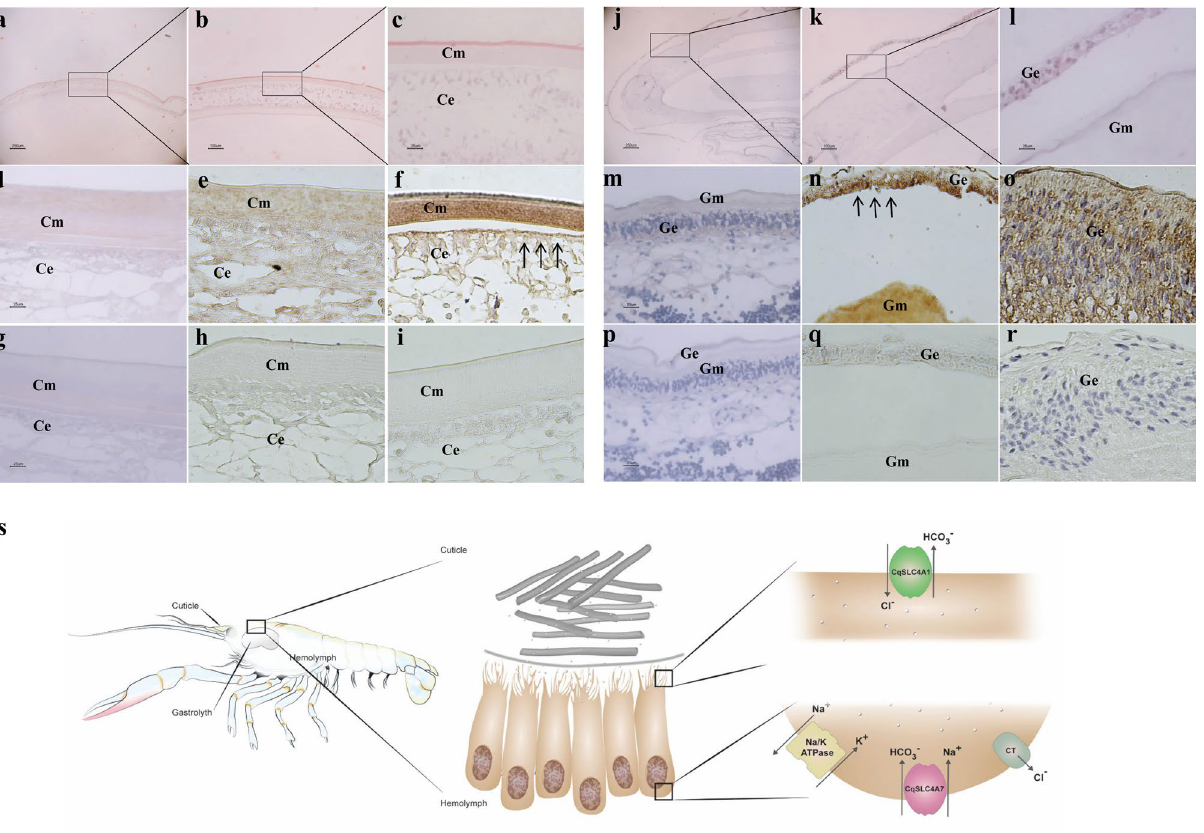
Figure 2. CqSLC4A1 is localized in the apical membrane of the forming epithelia of the cuticular structures of the crayfish during mineralization. ( a–c ) A representative carapace cuticle from a post-molt animal. H&E. ( a ) × 4. Black box and lines indicate the area magnified in ( b ) × 10. Black box and lines indicate the area magnified in ( c ) × 40. ( d–f ) Carapace cuticle incubated with anti-CqSLC4A1 from animals at different molt stages: ( d ) inter-molt, ( e ) late pre-molt, and ( f ) post-molt. ( g–i ) Carapace cuticle of control animals at different molt stages: ( g ) inter-molt, ( h ) late pre-molt, and ( i ) post-molt. ( j–l ) A representative gastrolith from a late pre-molt animal. H&E. ( j ) × 4. Black box and lines indicate the area magnified in ( k ) × 10. Black box and lines indicate the area magnified in ( l ) × 40. ( m–o ) Gastrolith incubated with anti-CqSLC4A1 from animals at different molt stages: ( m ) inter-molt, ( n ) late pre-molt, and ( o ) post-molt. ( p–q ) Gastrolith of control animals at different molt stages: ( p ) inter-molt, ( q ) late pre-molt, and ( r ) post-molt. Arrows indicate significant staining of anti-CqSLC4A1. Cm cuticular matrix, Ce cuticular epithelium, Gm gastrolith matrix and Ge gastrolith epithelium. ( s ) Schematic representations of the post-molt cuticular mineralization: Left—the molecular mechanism of bicarbonate transport in the forming epithelia of the cuticle and the gastrolith in a crayfish. Middle—forming epithelial cells underneath the cuticular extracellular chitinous scaffold. Right—putative locations of the different transporters in the epithelial cells and the predicted bicarbonate transport mechanisms involving CqSLC4A1 and CqSLC4A7 and transport-assisting mechanisms involving CqSLC12A2 and Na+/